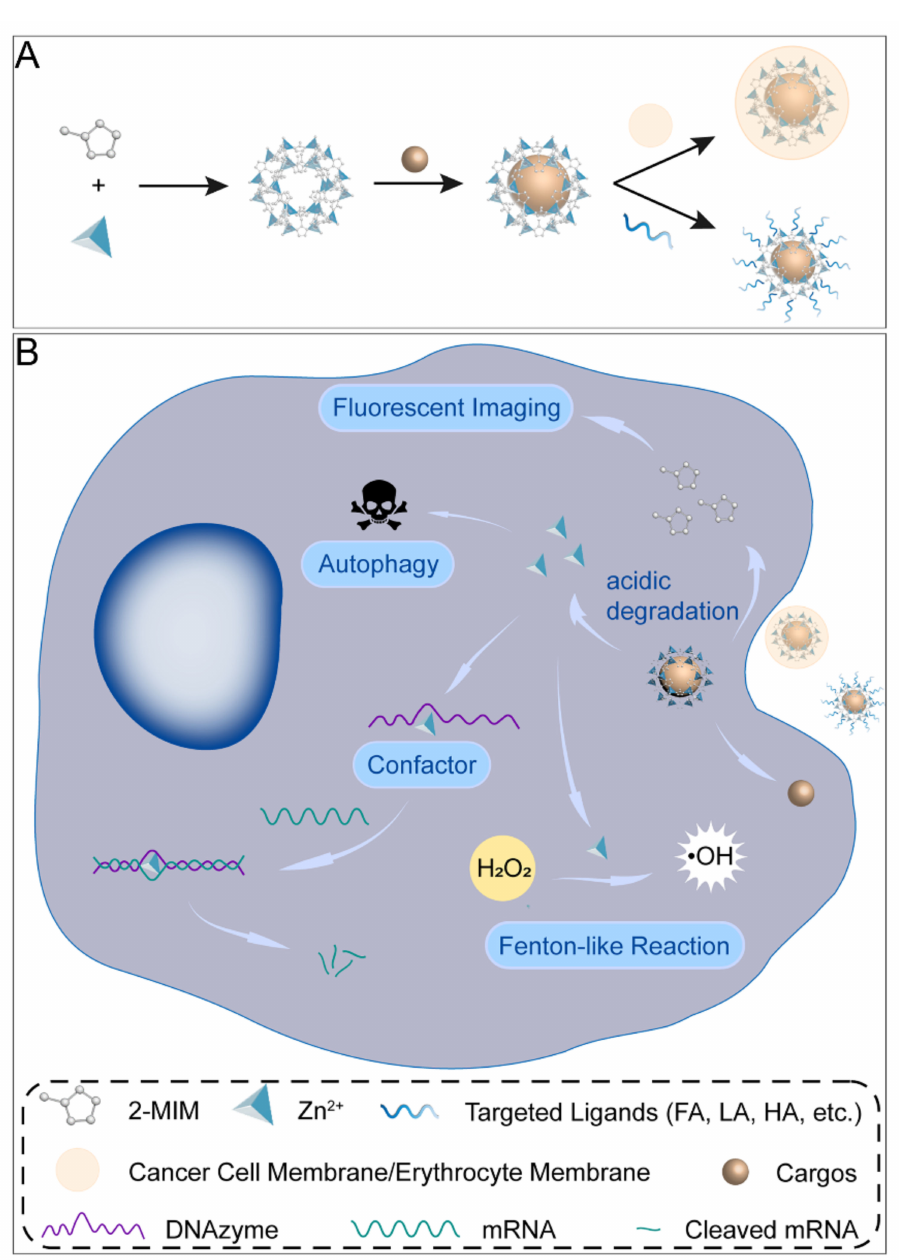
Figure 1. Synthesis process and decomposition of ZIF–8 nanocomposites in cancer cells. ( A ) Schematic presentation of the synthesis of ZIF–8 nanocomposites. ( B ) Illustration of ZIF–8 nanoformulations in cancer